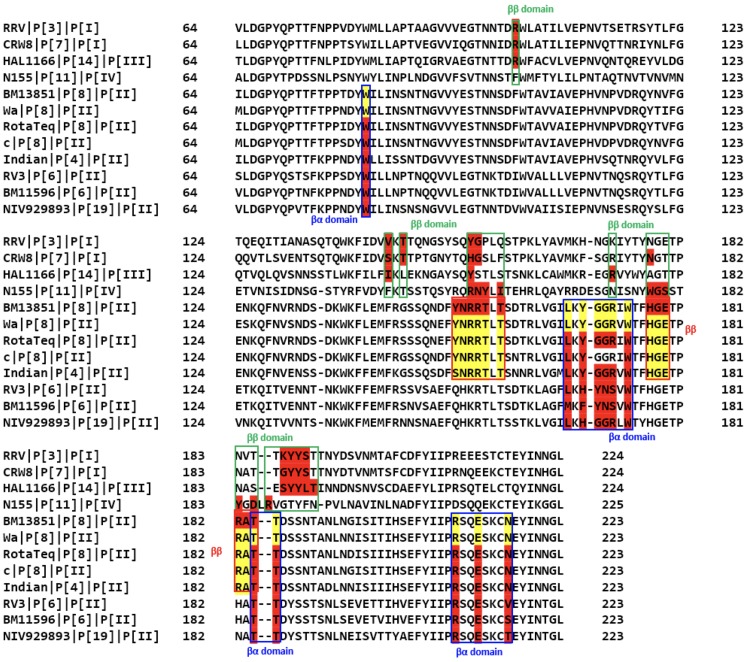
Structure-based sequence alignment of VP8* domains.The VP8* sequences of RVs with known binding sites are included. The VP8* sequences of P[19], P[6], P[4] and P[8] in P[II] genogroup, P[3], P[7] in P[I] genogroup, P[14] in P[III] genogroup and P[11] in P[IV] genogroup are included and the amino acids corresponding to the binding site are highlighted in red. Yellow highlights the potential binding site of Wa and other strains of P[8] VP8* in recognizing HBGAs.